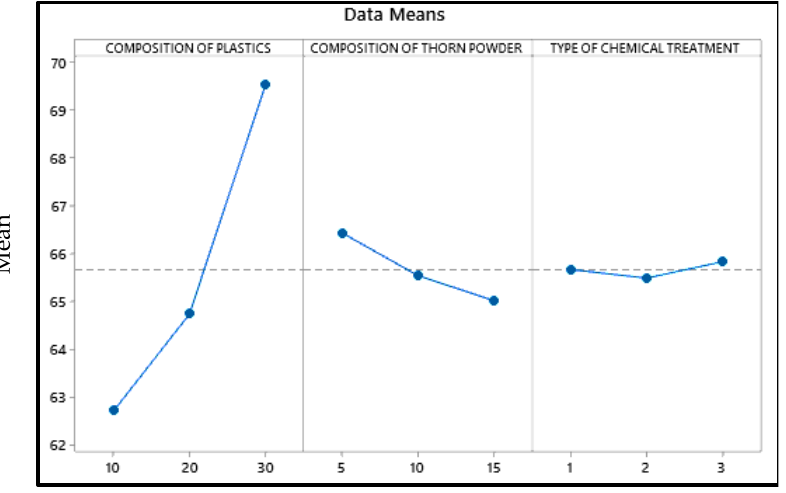
Table 5. Tensile strength results from DOE.